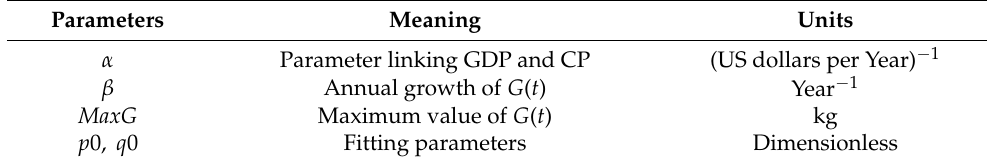
Fitting parameters